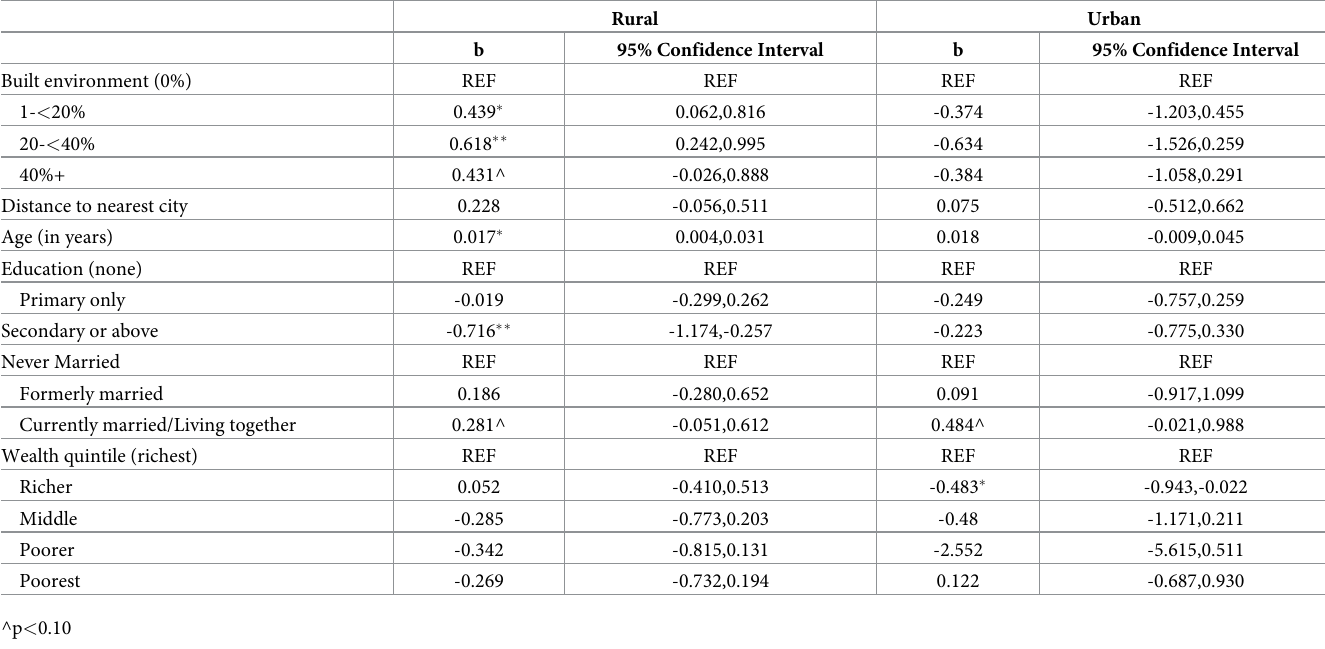
Table 4. Unstandardized beta coefficients from linear regression models of the association between log CRP and built environment stratified by urban/rural classification.